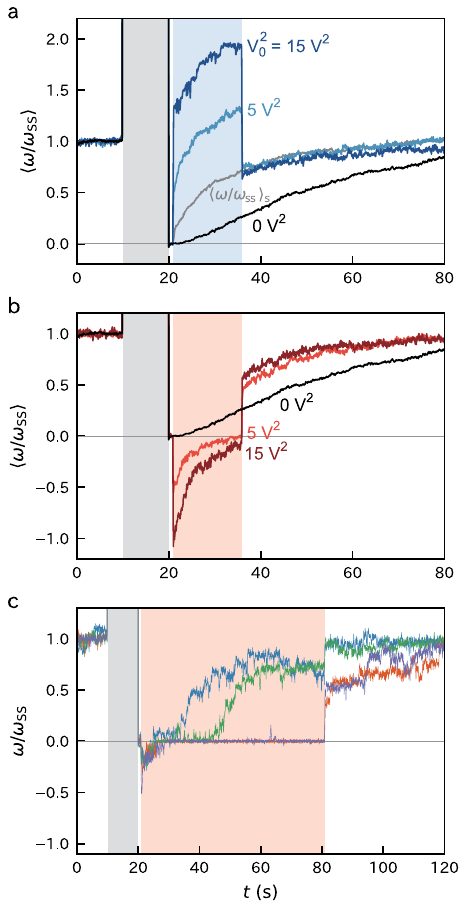
remodeling traces under constant external torque in the assisting direction ( a ) and hindering direction ( b ) with different V 2 . The torque was induced 0 for 15 s ( a , b ) or 60 s ( c ) starting at 21 s. The rotation rate ω was fi rst normalized by the steady rotation rate ω ss calculated as the mean ω during the initial phase and then averaged. The black and gray curves are the calibrated curves of 〈 ω 〉 and 〈 ω 〉 s of Fig. 2c. For 〈 ω 〉 s , the time origin was shifted to t = 21 s. See also Supplementary Fig. 6 for the combined plots of a and b for comparison. c , The remodeling process with extended torque induction in the hindering direction. Different colors correspond to different ¼ 3 (blue), 5 (green, orange), and 10 V runs. V 2 0